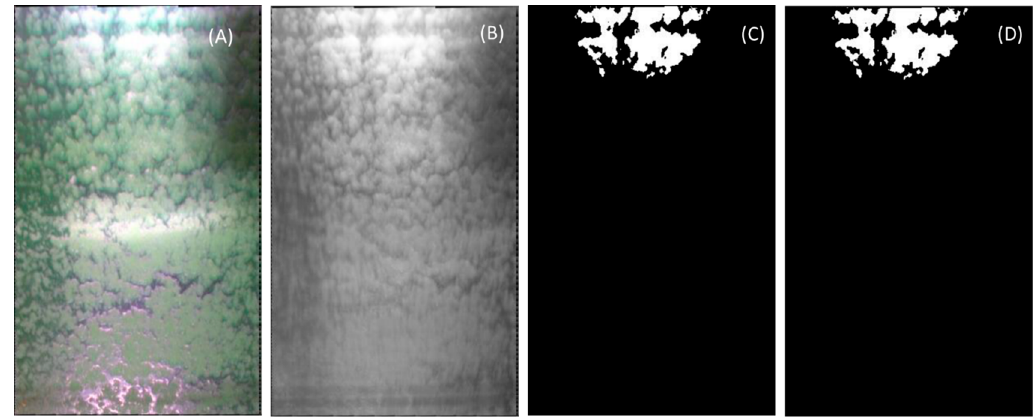
Figure 4. Algorithm of ice detection under light freezing rain: ( A ) original image, ( B ) Gaussian filter, ( C ) Homomorphic filter, ( D ) background, ( E ) difference between the image and the background, ( F ) addition with which has been detected previously, ( G ) binarization, ( H ) fill the holes, and ( I ) largest connected region.